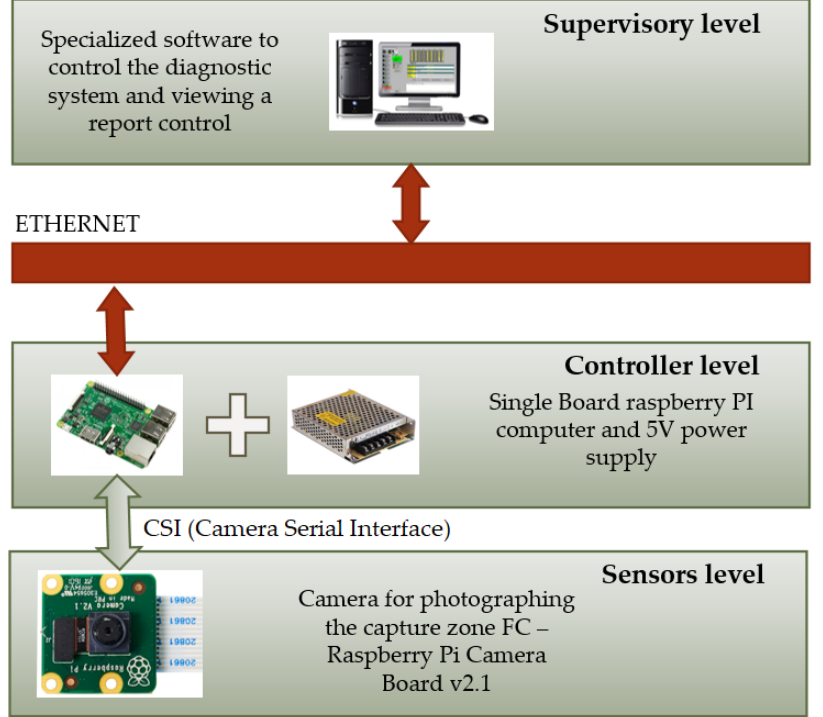
Figure 13. A block diagram of the automated diagnostics system for FC gripping accuracy.